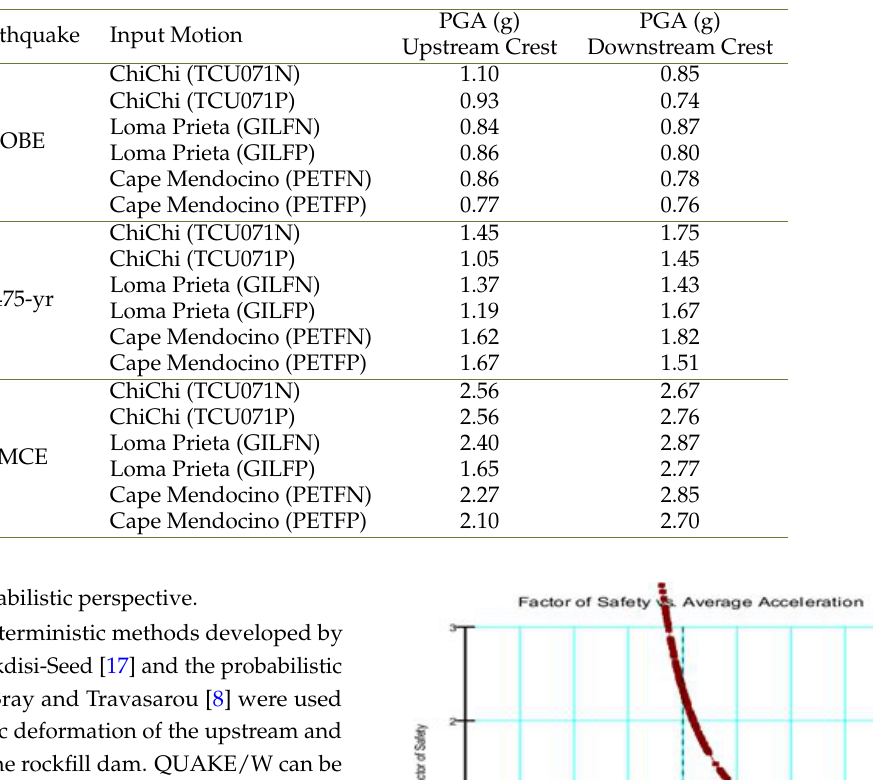
Table 3. PGA Obtained from Site Response Analysis.